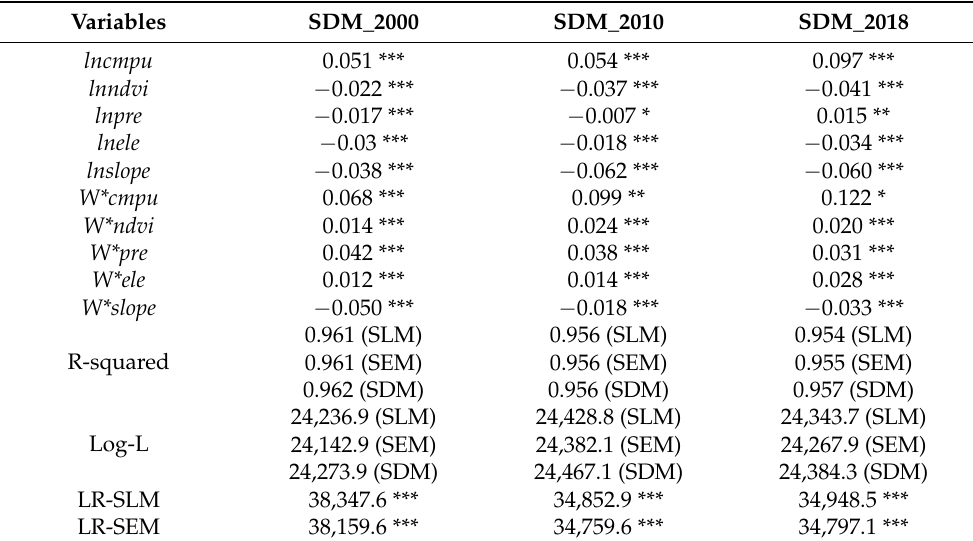
Table 4. Spatial regression model estimates of the driving factors of PM 2.5 concentrations in 2000, 2010, and